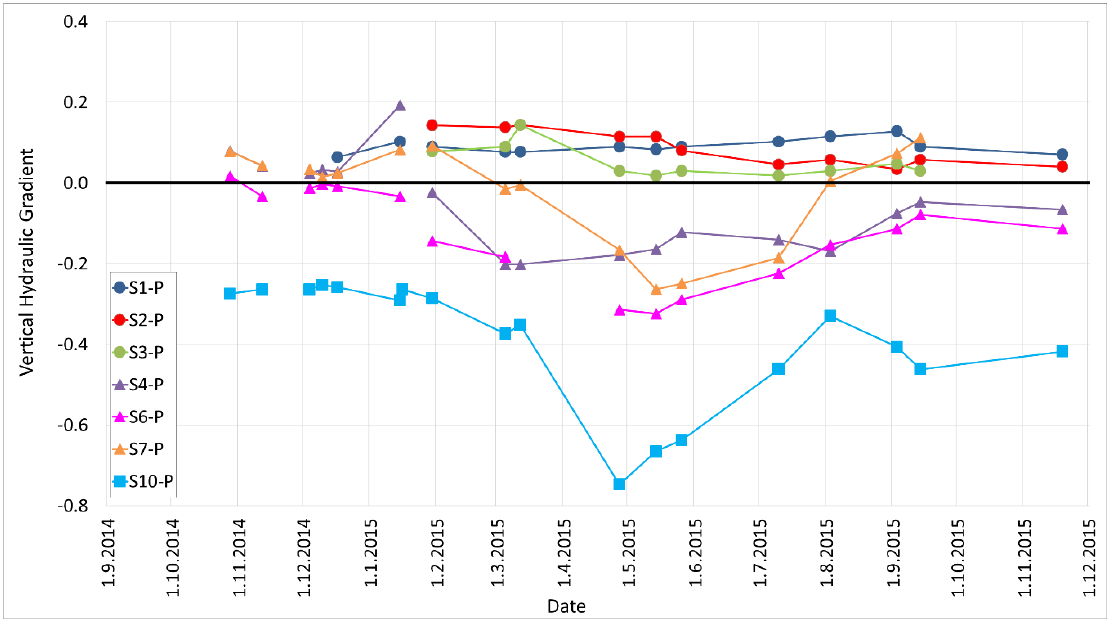
Figure 5. VHG variation in time for each piezometer location.